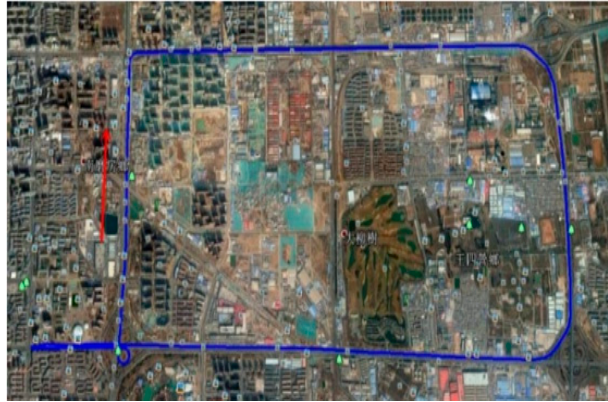
Figure 9. The vehicle trajectory.